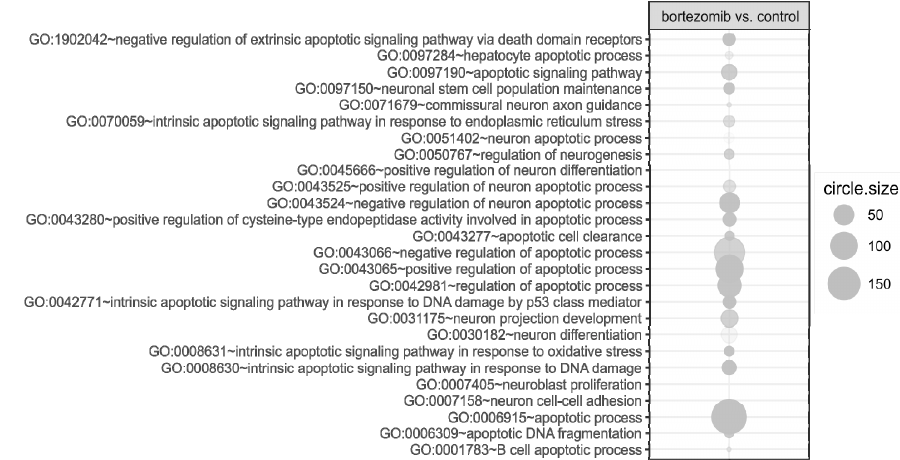
Figure 6. The bubble plot of overrepresented biological process involved in apoptosis and neurogenesis assigned according to gene ontology (GO) classification in bortezomib-treated SH-SY5Y cells compared to the control cells Groups of genes fulfilling criteria: Adjusted p < 0.05, method = Benjamini, and minimum number of miRNAs per group = 5, are presented. Bubble size indicates the number of miRNAs represented in corresponding annotation.